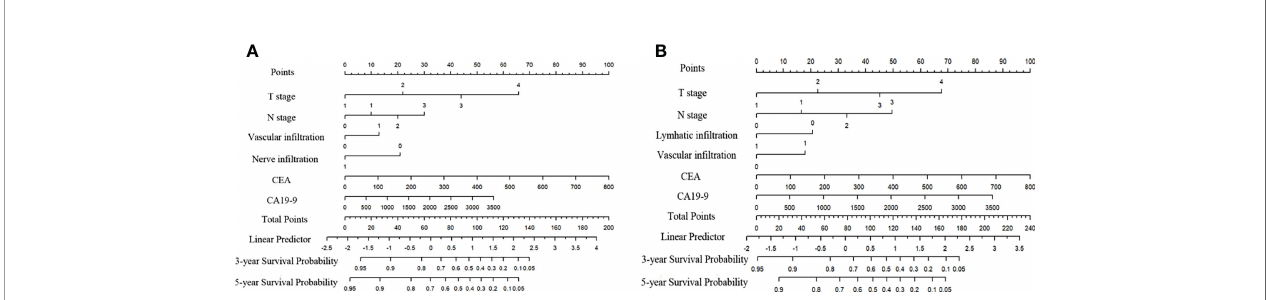
FIGURE 3 | Nomograms for variables from the internal training cohort included in the signatures. (A) Nomogram for variables included in the model for DFS in GC. (B) Nomogram for variables included in the model for OS in GC. Lymphatic in fi ltration, vascular in fi ltration, nerve in fi ltration: 0-absent, 1-present. Differentiation: 1- high, 2-moderate, 3-low, 4-undifferentiation.